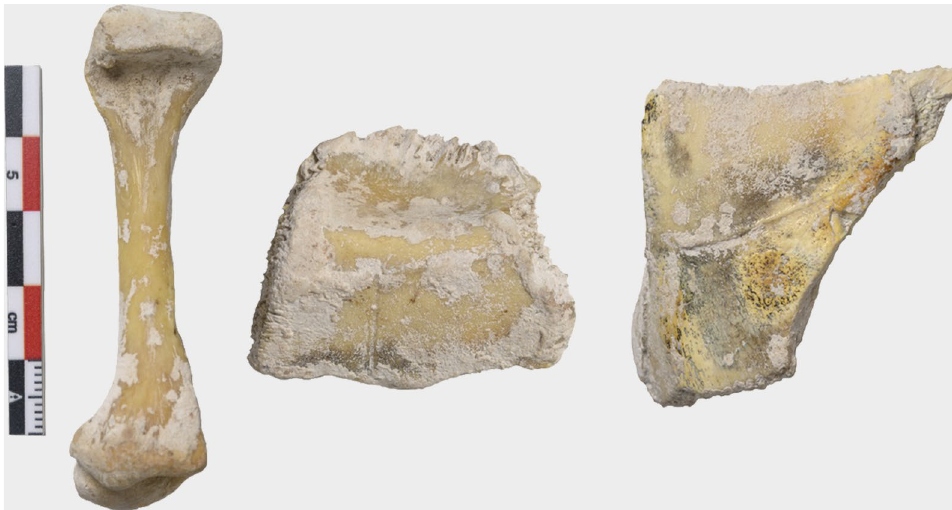
Figure 2. Type material of Geochelone atlantica López-Jurado, Mateo and García-Márquez, 1998 in the collection of the Departamento de Biología, Universidad de Las Palmas de Gran Canaria. From the left to the right: holotype (DBULPGC 17, right femur), paratype (DBULPGC 18, second peripheral bone), and paratype (DBULPGC 19, third peripheral bone; photos: N.